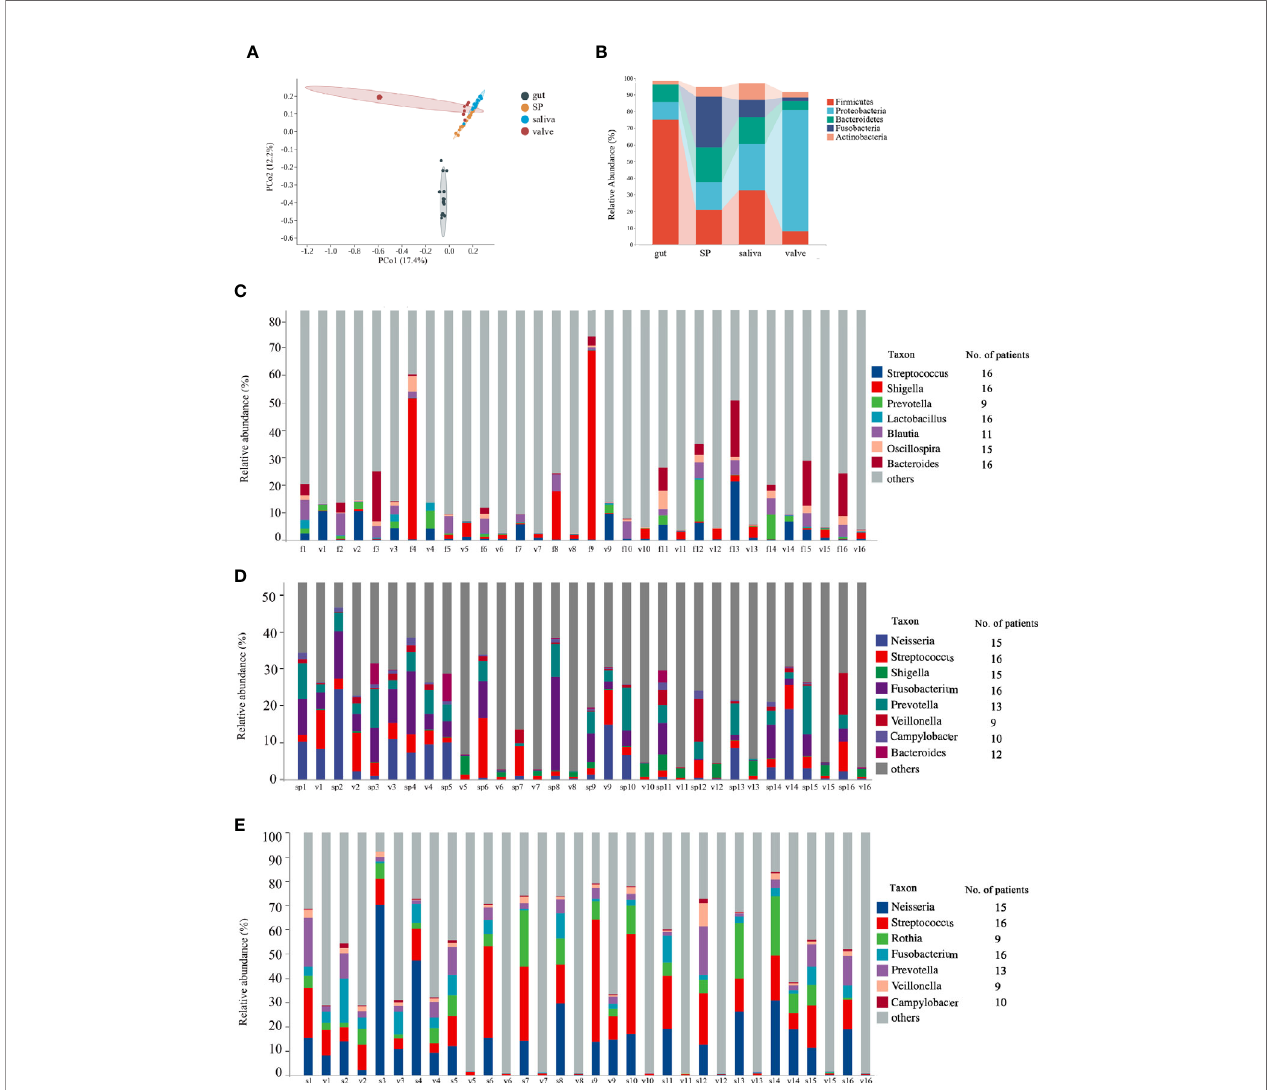
FIGURE 4 | Comparisons of microbiota composition between mitral valves and other body sites of patients with rheumatic heart disease. Microbiota of mitral valves from patients with rheumatic heart disease (RHD) were analyzed using 16S rRNA gene sequencing. (A) Comparison of microbial b -diversity (PCoA) among gut, subgingival plaques (SP), saliva, and mitral valves (valve) of RHD patients. (B) Taxonomic composition of microbiota at different body sites of RHD patients at phylum level. (C) Illustration of genera detected in both fecal sample (f) and mitral valve (v) of each RHD patient. The numbers (1 – 16) denote RHD patients. The column on right indicates the number of patients who possess the corresponding genus in both sites. (D) Illustration of genera detected in both subgingival plaque (sp) and mitral valve (v) of each RHD patient. (E) Illustration of genera detected in both saliva (s) and mitral valve (v) of each RHD patient. n =